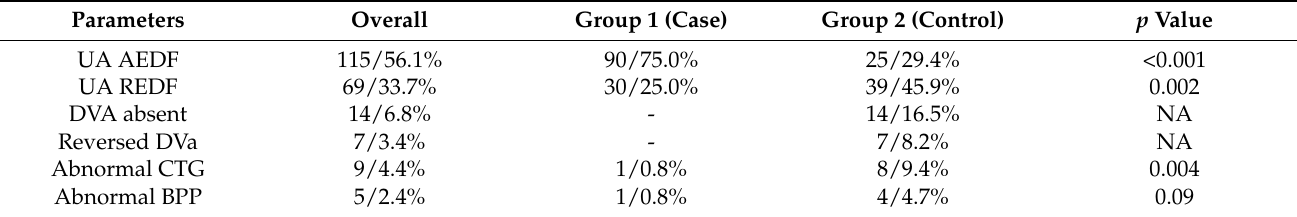
Table 2. Doppler findings in 205 early onset FGR fetuses.